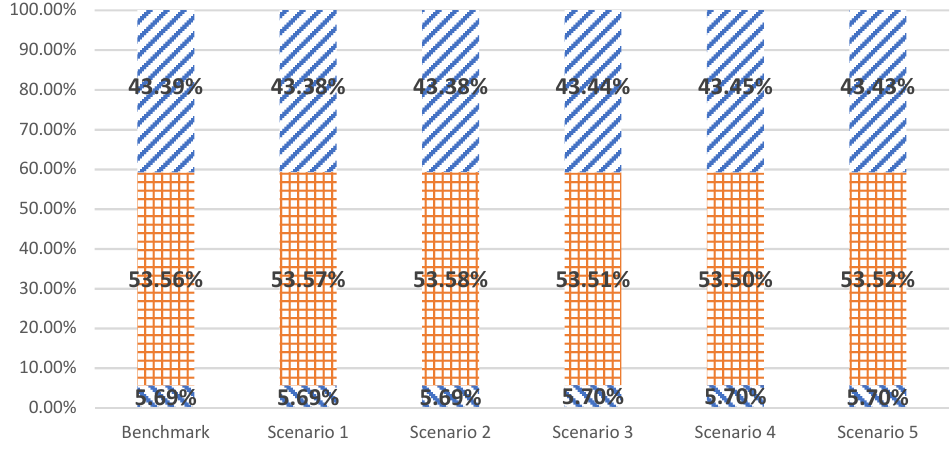
Figure 6. Share of China’s industries in the GDP in 2030 under different scenarios.